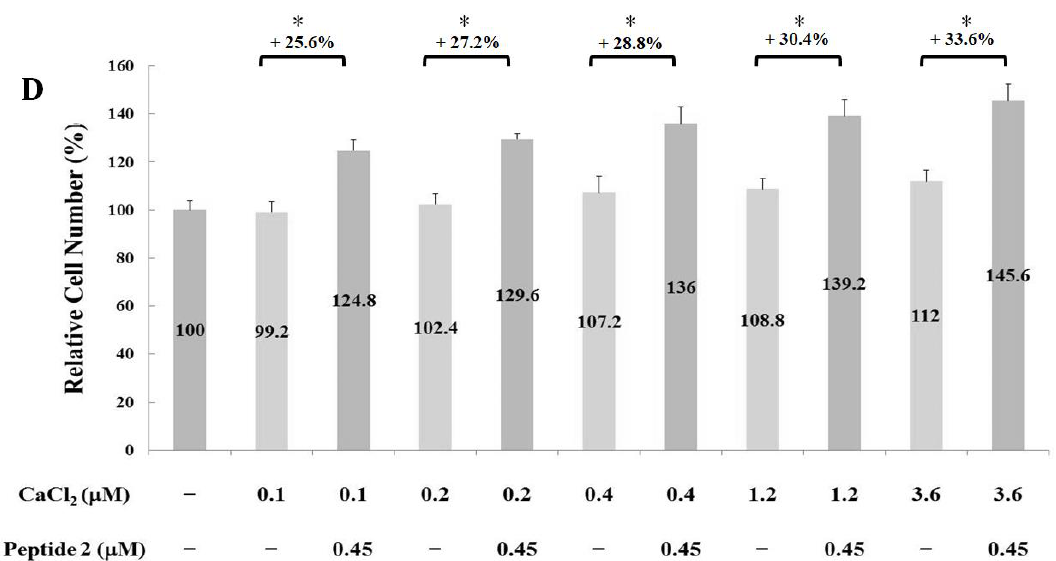
Figure 3. Synergistic effects of calcium ions with each of the four peptides. Note: Osteoblast pro- liferation activity was represented as the cell number. Data are presented as means ± SD in three independent experiments. The differences between the peptide combined with CaCl 2 treatment and the only CaCl 2 treatment groups ( A – D ) were analyzed using a one‑tailed test, * p < 0.05 and ** p < 0.005.